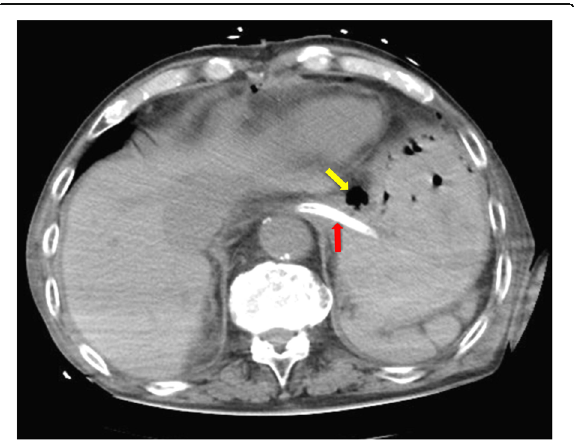
Fig. 2 Computed tomography image on postoperative day 1, showing localized free air in the abdominal cavity. The yellow arrow indicates an area of free air between the left lateral segment of the liver and the lesser curvature of the stomach. The red arrow indicates the nasogastric tube from the lower esophagus to the